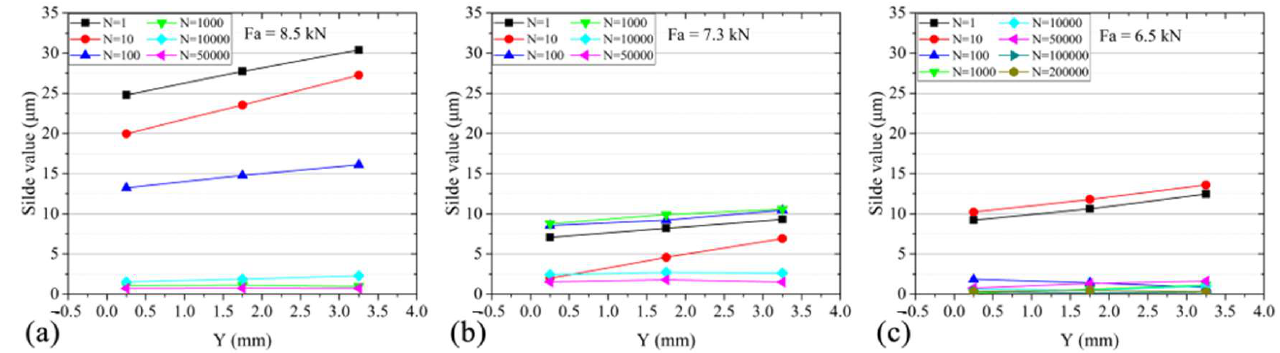
Figure 12. Distribution of relative slip along the contact surface for the ( a ) 8.5 kN, ( b ) 7.3 kN, and ( c ) 6.5 kN cases.